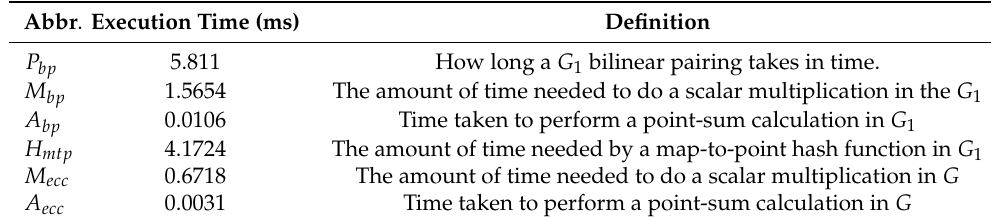
Table 4. The time required for various cryptographic operations Abbr . Execution Time